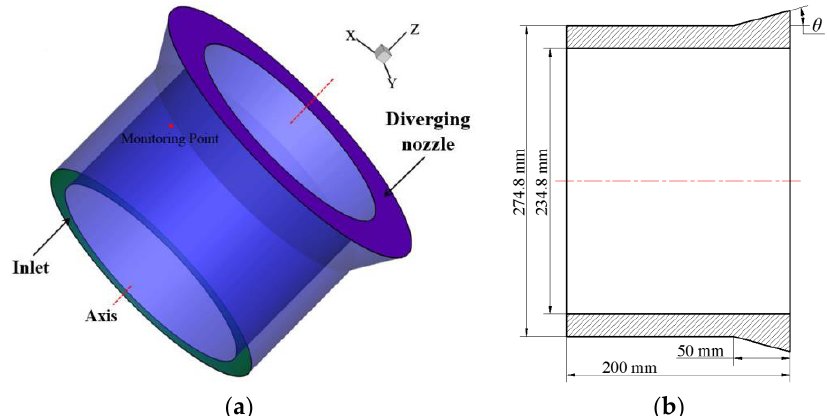
Figure 1. ( a ) Three-dimensional geometry; ( b ) size of the premixed rotating detonation combustor (RDC).